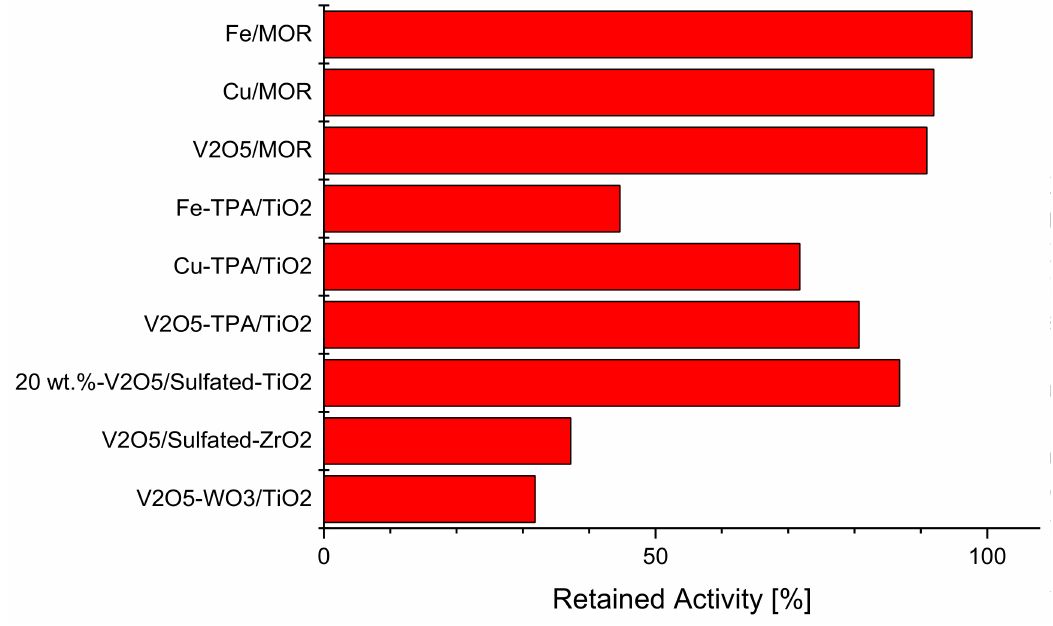
Figure 1. Retained activity at 400 ◦ C upon impregnation with 100 µ mol K g − 1 for V 2 O 5 /sulfated-ZrO 2 ). Reproduced from